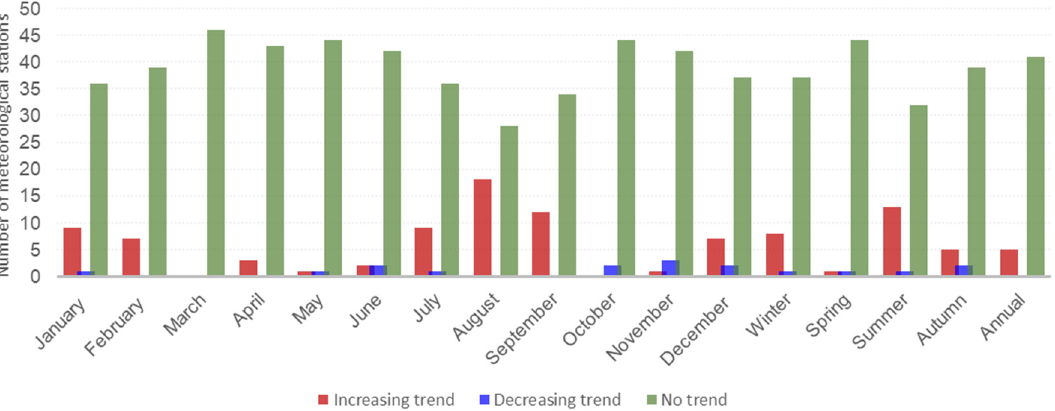
Figure 3. Summary of the trend of PET at different temporal scales.